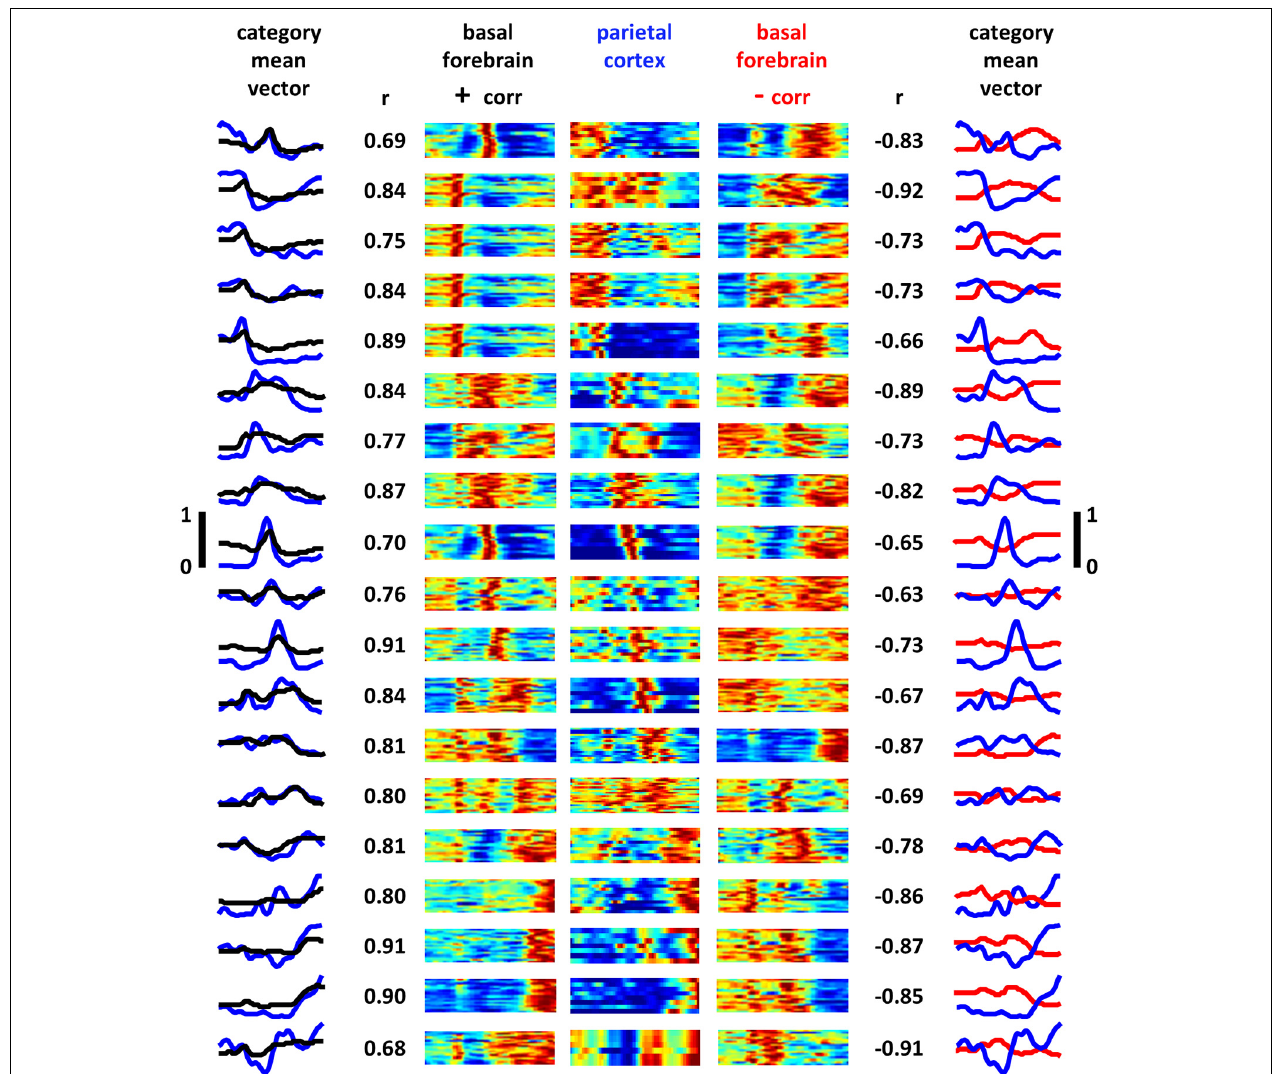
FIGURE 7 | Posterior parietal cortex task-phase-specific firing patterns parallel those of basal forebrain. Task-phase-specific firing rate vectors for all recorded PPC neurons ( N = 203) were grouped into 19 categories according to the method described in Supplemental Figure 3 (see also experimental procedures). The center panels are the full max-normalized firing rate vectors for all task phases for all PPC neurons (y-axis is neurons, x-axis is task phase, blue-red = 0–1). Neighboring color maps to the left and right correspond to full firing rate vectors of all BF neurons for the category of BF neurons whose mean cross-neuron rates bear the greatest overall similarity (left panels) and dissimilarity (right panels) to the